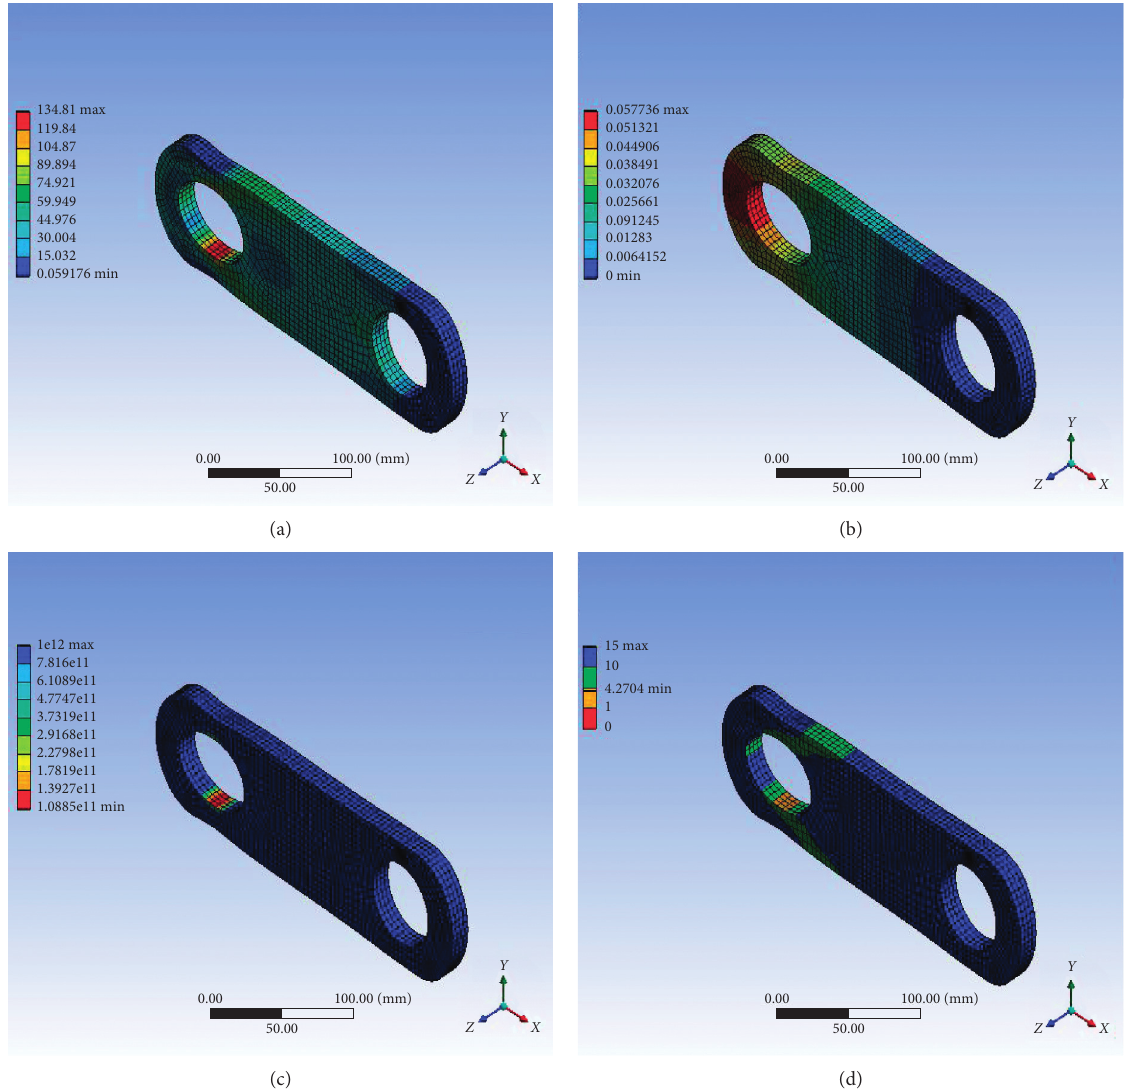
Figure 8: Simulation results for chain link without a modeled crack with neck radius 500 mm ( X � 1mm): (a) equivalent stress, (b) deformation, (c) fatigue life, and (d) safety